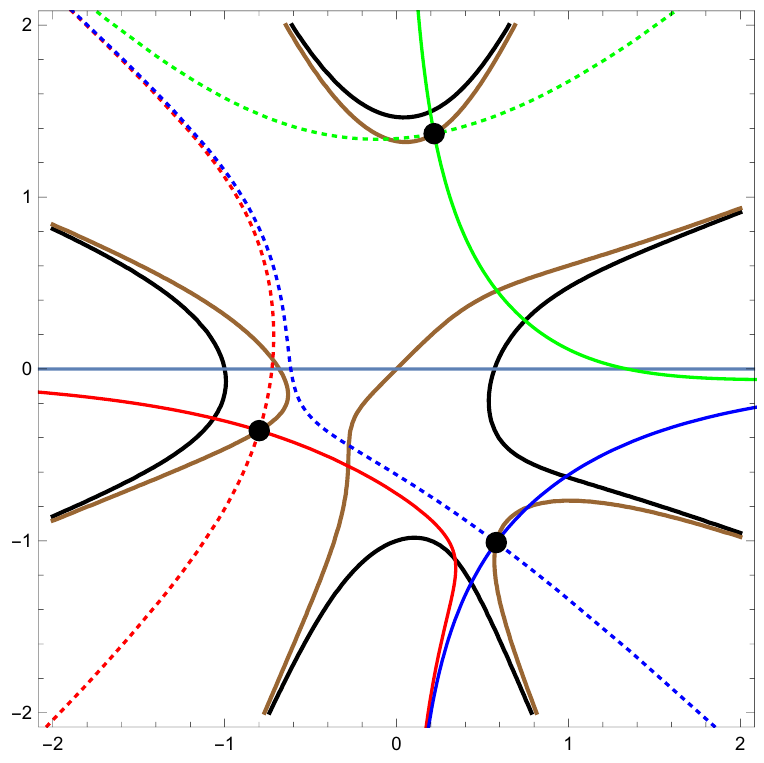
Figure 7: Pole and thimble structure for the z 4 model enforcing the two constraints (30) and (33), each represented in the original variable z . Red, green and blue solid (dashed) lines are the (anti-)thimbles and black points denote the fixed points. The brown solid lines are the poles from the constraint Im [ S solid lines represent the poles from the constraint Im [ S